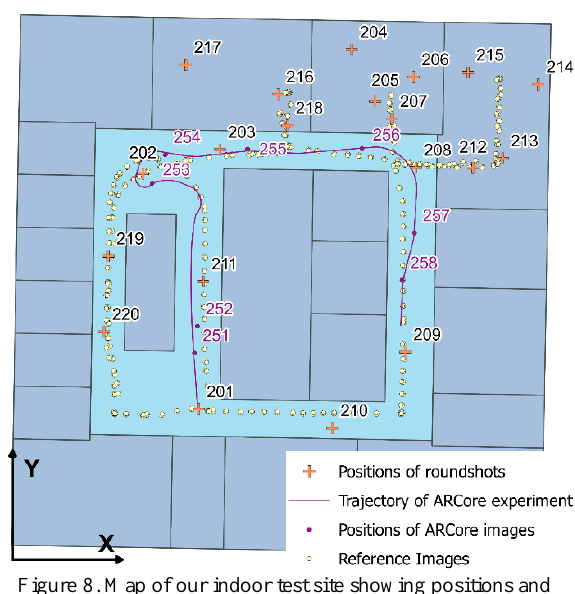
Figure 8. Map of our indoor test site showing positions and